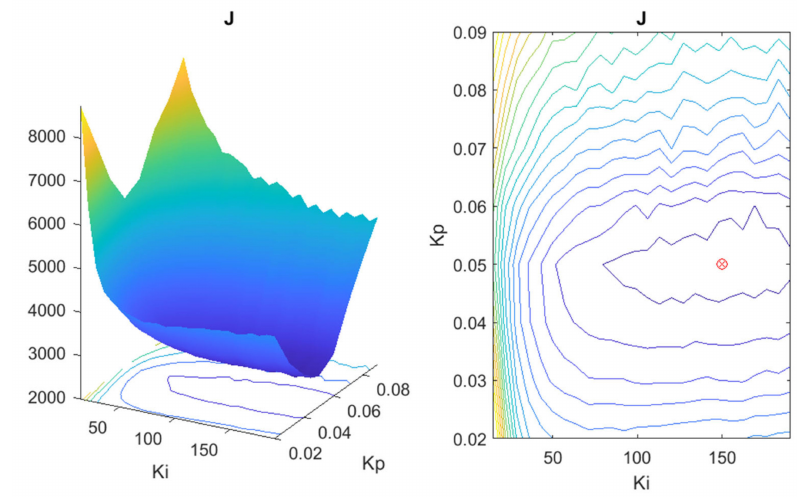
Figure 8. Cost function vs. parameters of the PI controller.